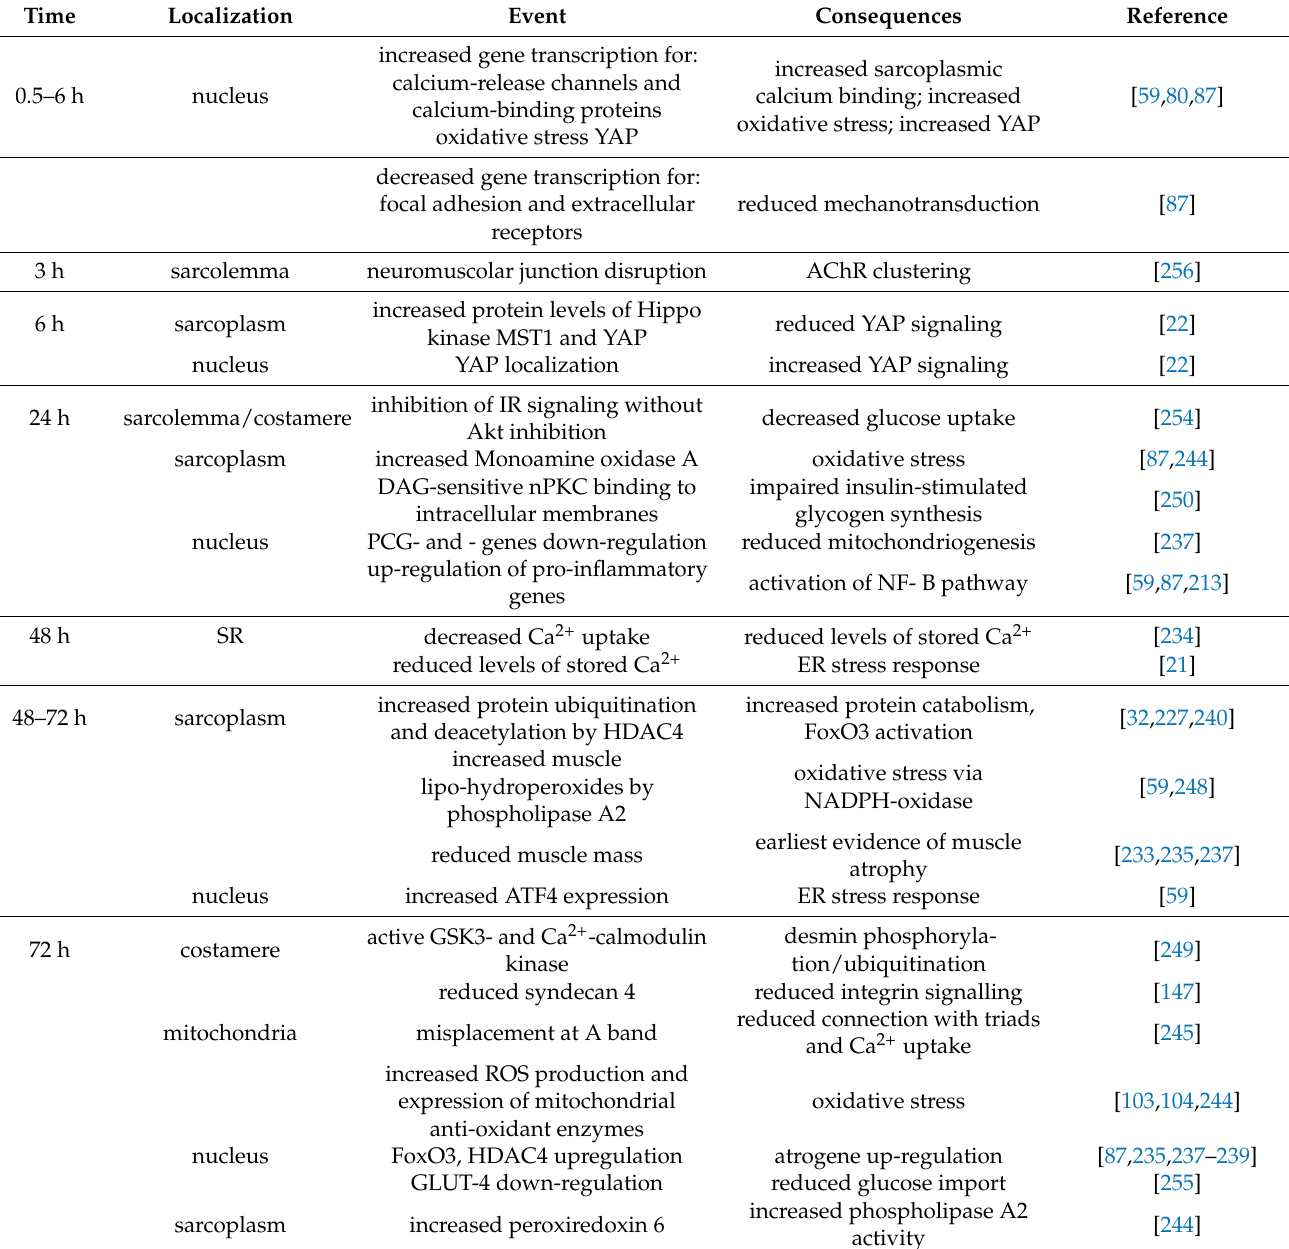
Table 2. Temporal sequence of events induced by denervation in rodent hindlimb muscles before the appearance of myofiber